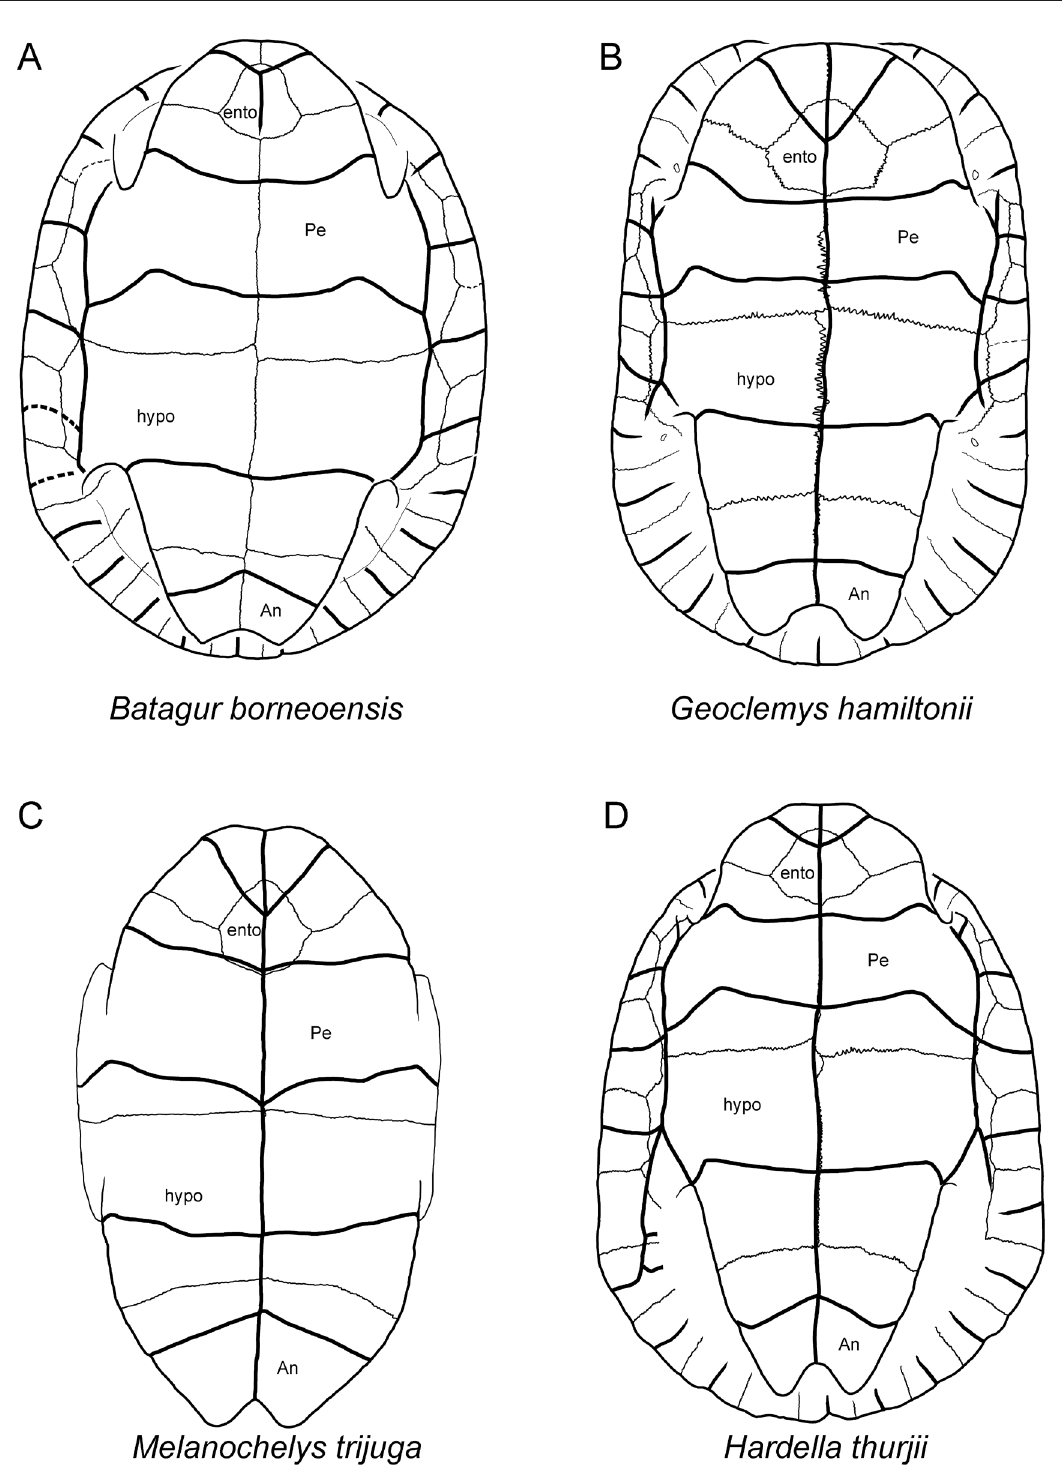
Fig. 3. Illustration of the plastron of four extant geoemydid species that were used for morphological comparison with Siwalik specimens. A . Plastron of Batagur borneoensis (Schlegel & Müller, 1845) (FMNH 251499), a geoemydid from Borneo that here illustrates the general shape of species of Batagur Gray, 1856. B . Geoclemys hamiltonii (Gray, 1830) (NMW 39986), a geoemydid from the Indian subcontinent C . Melanochelys trijuga (Schweigger, 1812) (NMW 37159), a geoemydid from the Indian subcontinent. D . Plastron of Hardella thurjii (Gray, 1831)